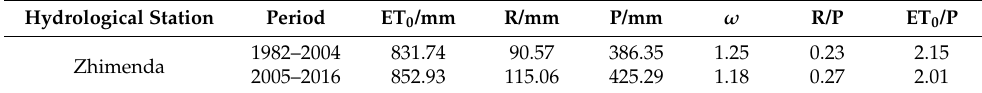
Table 1. Eigenvalues of meteorological and hydrological variables in the